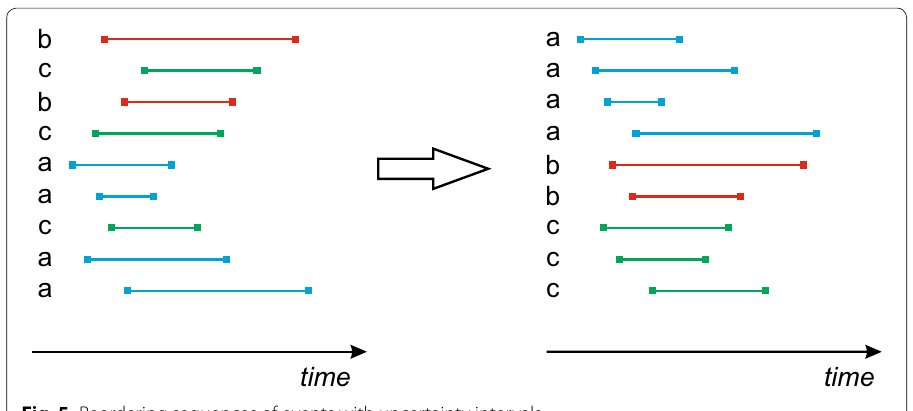
Fig. 5 Reordering sequences of events with uncertainty